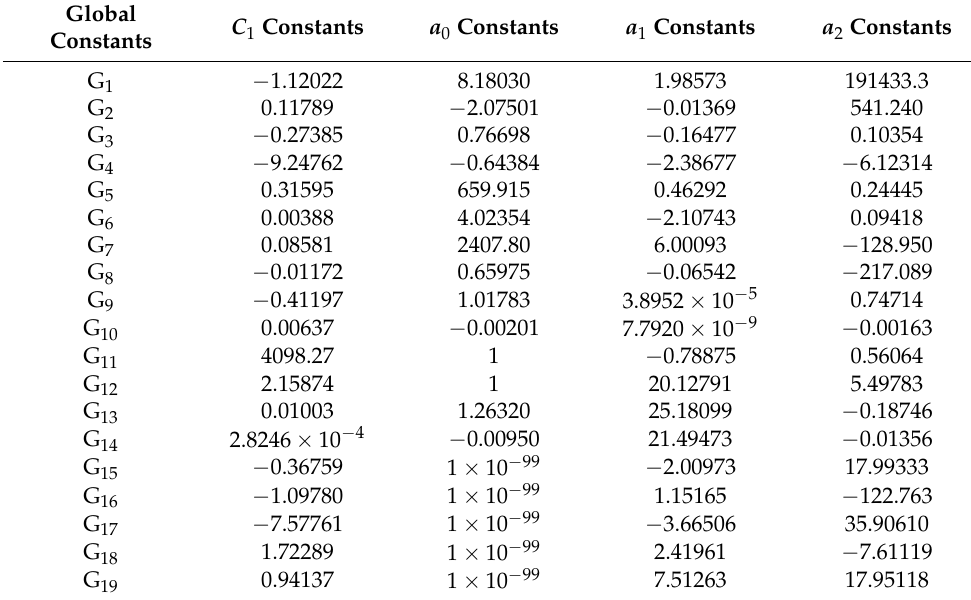
Table 4. Global tuning constants for the physics-based IMEP model.